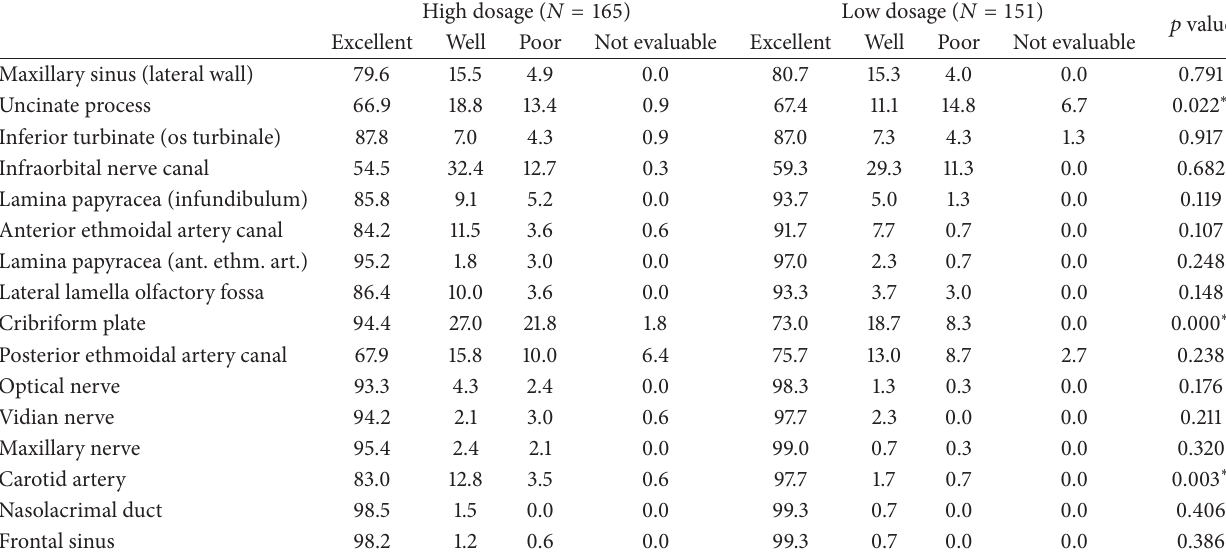
Table 2: Overview of the frequencies in percent of the evaluation of the visibility of the different anatomical structures in the two groups (high dosage versus low dosage) with the corresponding 𝑝 values ( ∗ values marked with an asterisk are highly